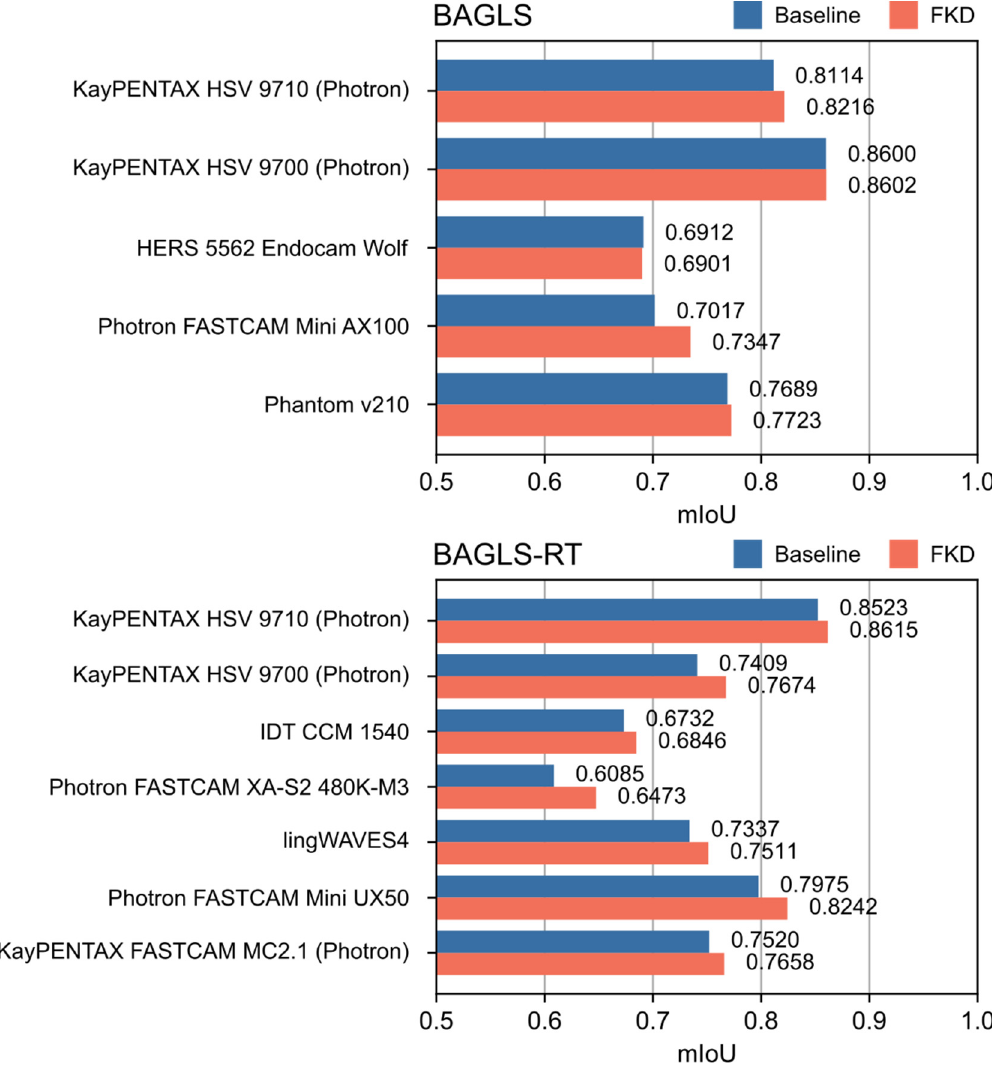
Figure 10. Segmentation performance (IoU) of the baseline U-Net and the U-Net after finetuning with knowledge distillation (b = 100%) for each camera system within the BAGLS and BAGLS-RT datasets.